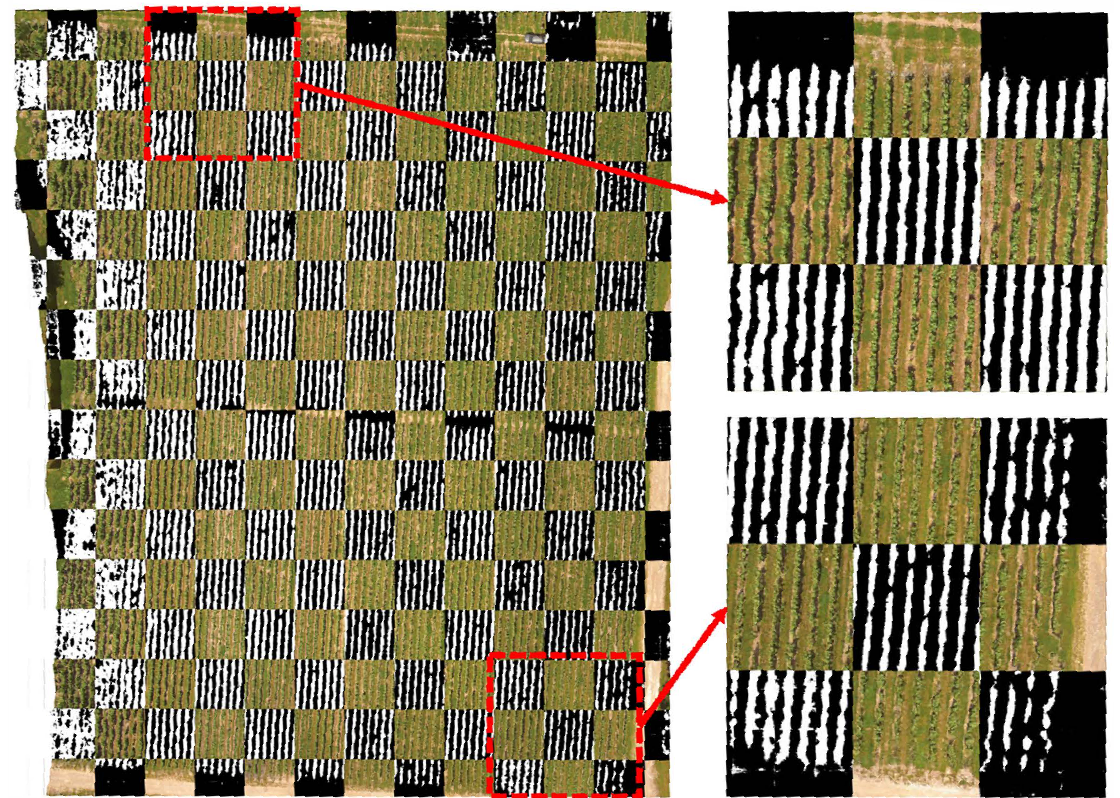
Figure 6. Evaluation of the depth map alignment using a chessboard